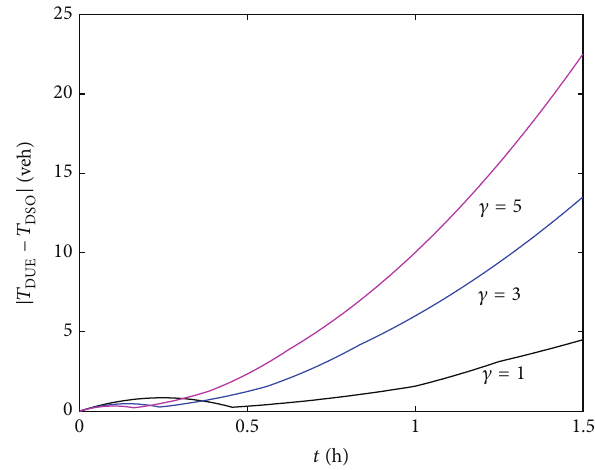
Figure 6: The distance between 𝑇